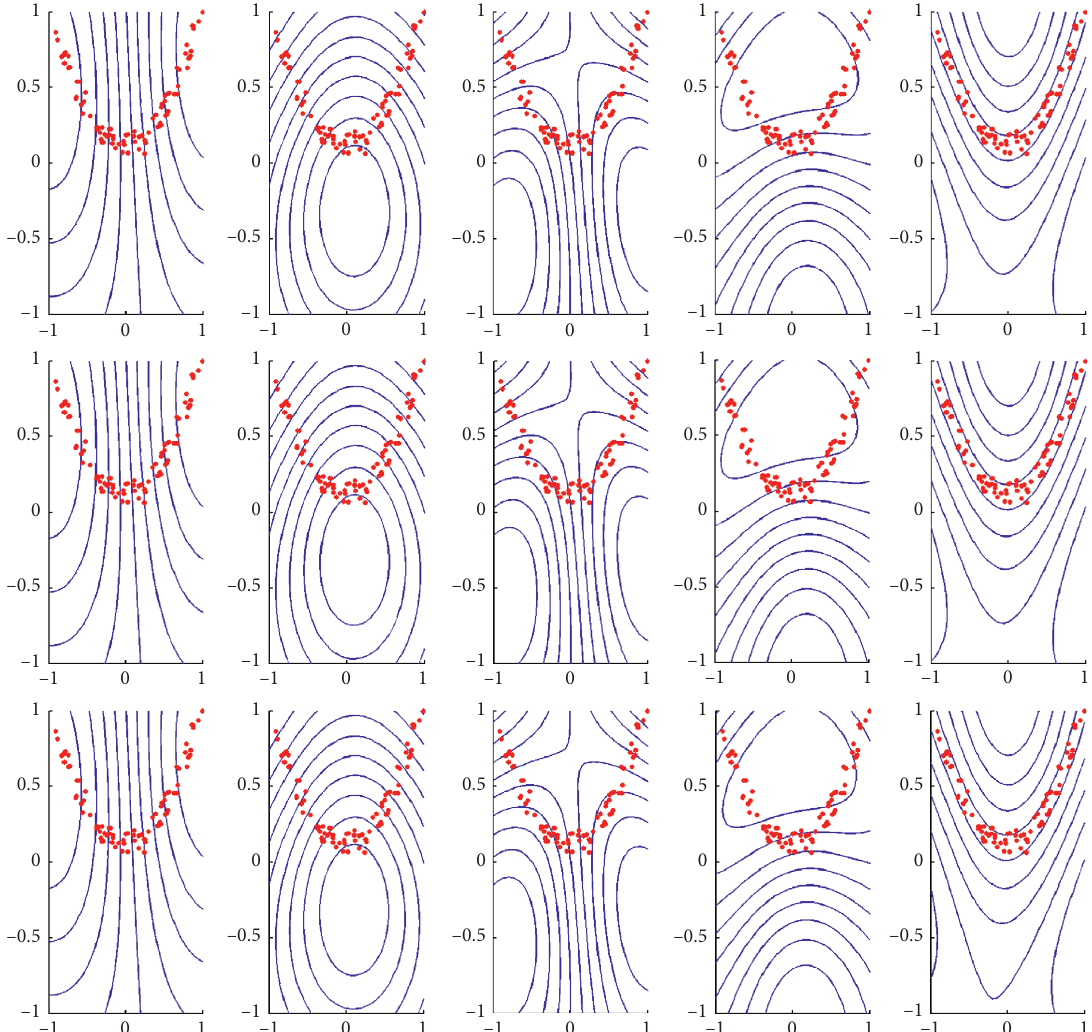
Figure 1: Two-dimensional examples. From top to bottom, the results of vector-based KPCA, standard MKPCA, and the proposed method, respectively. From left to right, projection contour lines onto the first five kernels principal component (red points denote input